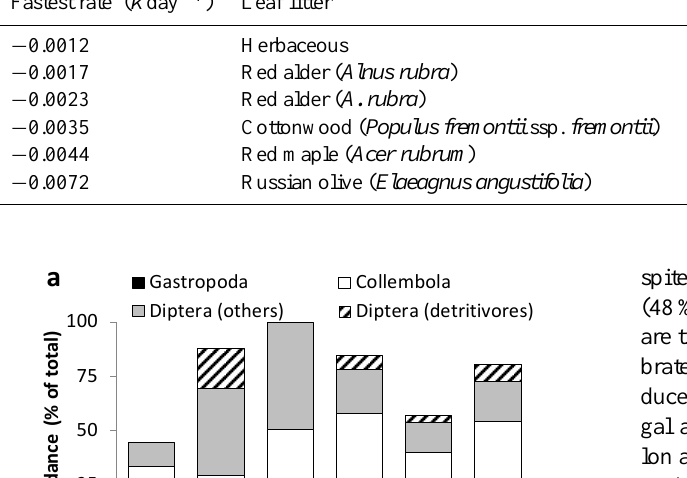
Table 3. Fastest breakdown rates of leaf litter obtained in several studies at riparian areas. Fastest rate ( k day − 1 )